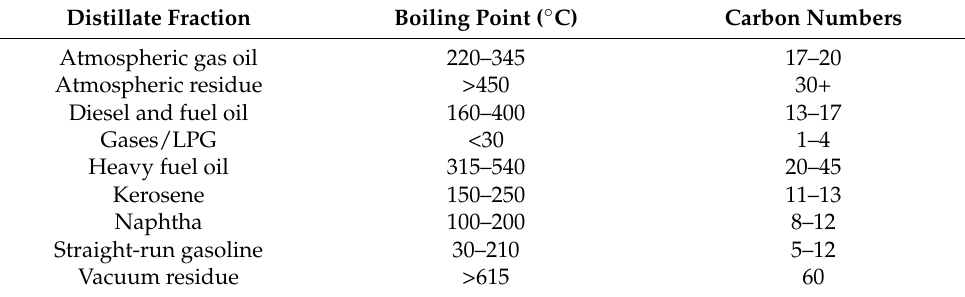
Table 1. Petroleum distillate fractions and their boiling points.